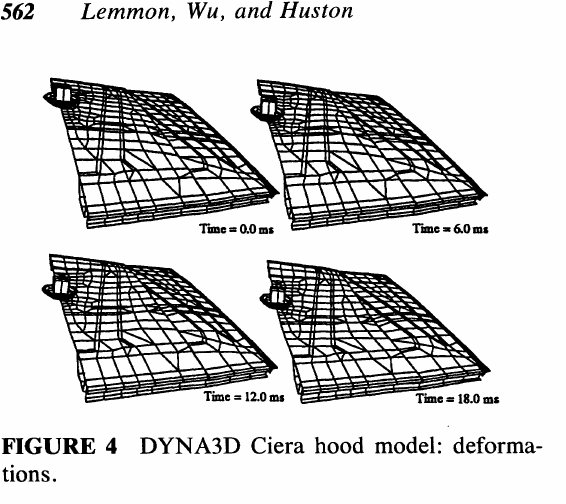
FIGURE 4 DYNA3D Ciera hood model: deforma tions.